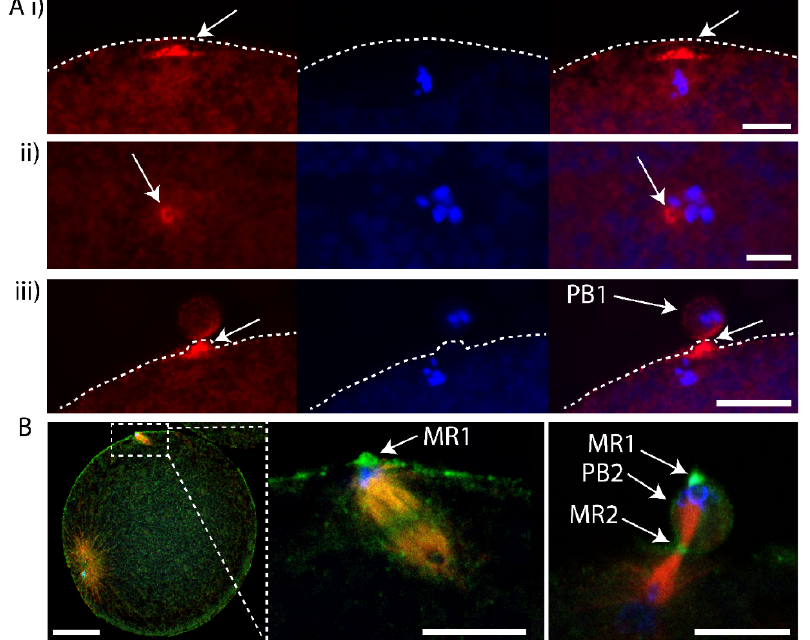
Figure 3. First midbody remains associated with the fertilized egg following PB1 emission. ( A ) Fertilized eggs were fixed during meiosis II and stained using Phalloidin::TRITC to label actin and Hoechst to label chromosomes. (i) Confocal images showing actin cap (arrows) during meiosis II in an egg following PB1 removal. (ii) Confocal images showing actin labelling of the midbody (arrows) during meiosis II in an egg following PB1 removal (arrows). (iii) Control egg that displayed PB1 attached to the egg surface. Please note that the midbody is strongly labelled with Phalloidin (arrows). Dotted line indicates surface of the egg. Scale bars = 10 µ m. n > 50 for (i) and (ii) where Phalloidin labelled the actin cap (i) and midbody (ii). n > 50 for Phalloidin labelling of outpocket (iii). ( B ) Fertilized eggs were pipetted during meiosis II to remove PB1, fixed and labelled with anti-phospho aPKC (green), anti-tubulin (red) and DAPI (blue). Left image: overlay showing the rotated second meiotic spindle. The sperm aster is also visible, far left. Scale bar = 30 µ m. Middle image: inset of boxed region showing that one pole of second meiotic spindle is aligned with PB1 midbody remnant (MR1 arrow). Please note that PB1 was removed by pipetting. Scale bar = 10 µ m. Right image: Another fertilized egg which had already emitted PB2 showing location of first midbody remnant (MR1, arrows), second midbody remnant (MR2, arrow) and PB2 (arrow). Please note that PB1 was removed by pipetting. n > 50 zygotes where aPKC labelled the midbody remnant. Scale bar = 10 µ m. Also see Supplementary Movies S4 and S5 of LifeAct labelling.